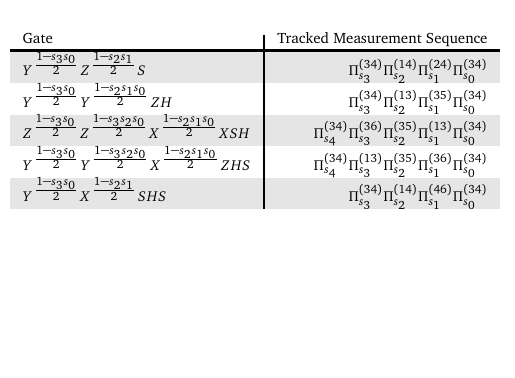
Table 8: Minimal difficulty weight measurement sequences for controlled-Pauli two-qubit gates when using forced-measurement methods. The labels ( u ) , ( d ) , ( r ) , and ( l ) indicates that for a hexon acting as the control qubit of the C ( P ) gate, the corresponding target qubit is the nearest neighbor hexon in the up, down, right, and left direction, respectively. Notice that the choice of control and target qubit is arbitrary for C ( Z ) , so ( u ) and ( d ) are related by symmetry, as are ( r ) , and ( l ) . The average difficulty weight of the four directions is labeled by ( a ) . For comparison, we also present the corresponding realization of the gates formed by using the generating gate sets 〈 S , H , C ( Z ) 〉 and 〈 S , B , W 〉 . A C ( Z ) = A denotes conjugation of C ( Z ) by A on the target